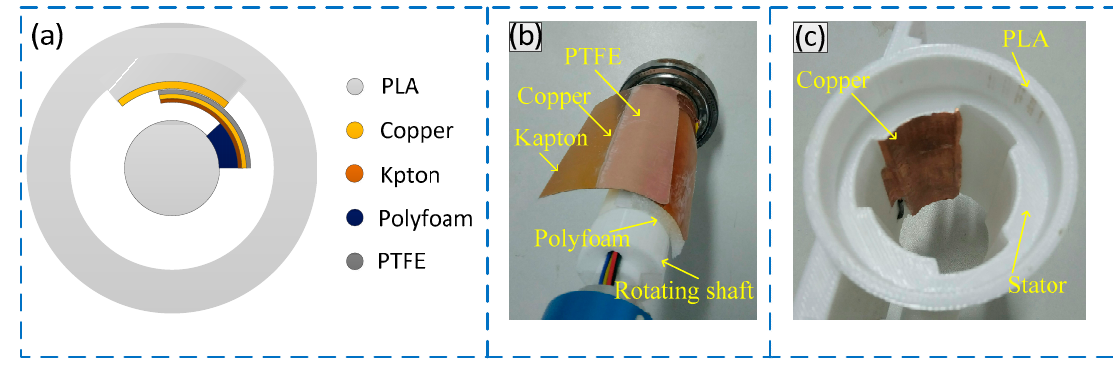
Figure 1. Schematic diagram of the sensor structure. ( a ) Schematic diagram of the overall structure; ( b ) picture of rotating shaft of the sensor; ( c ) picture of the sensing stator.